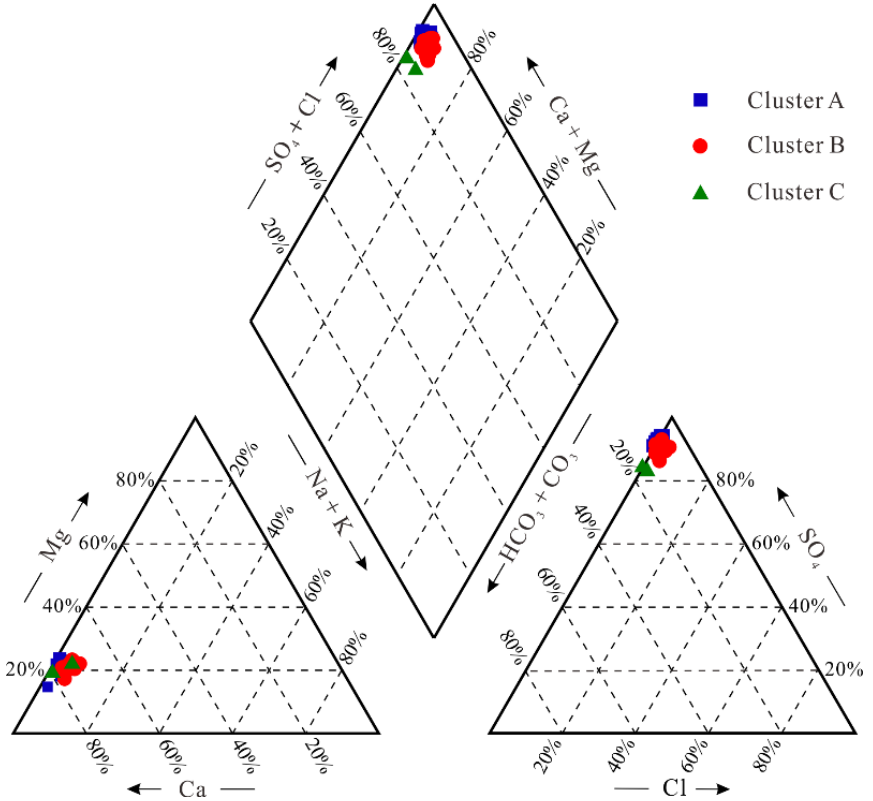
Figure 7. Piper diagram of the thermal groundwater samples. Table 1. Average and standard deviation of hydrochemical parameters for three clusters water samples (in mg / L except T and